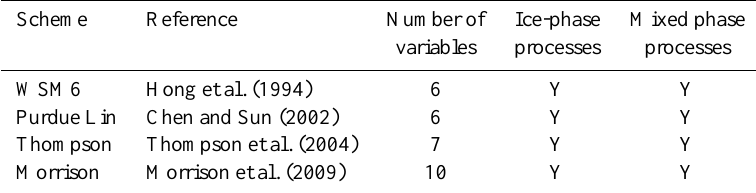
Table 1. Details of the microphysical schemes considered in the